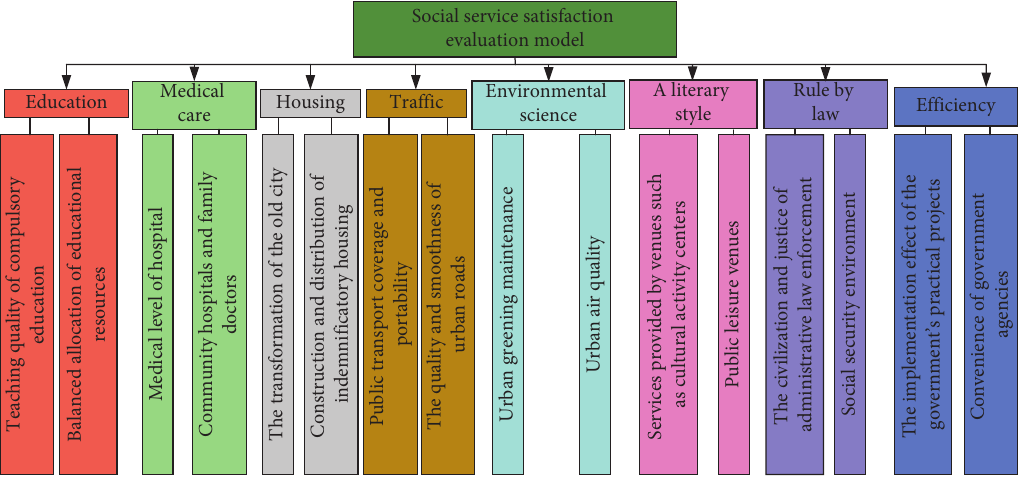
Figure 5: A model of influencing factors of social service